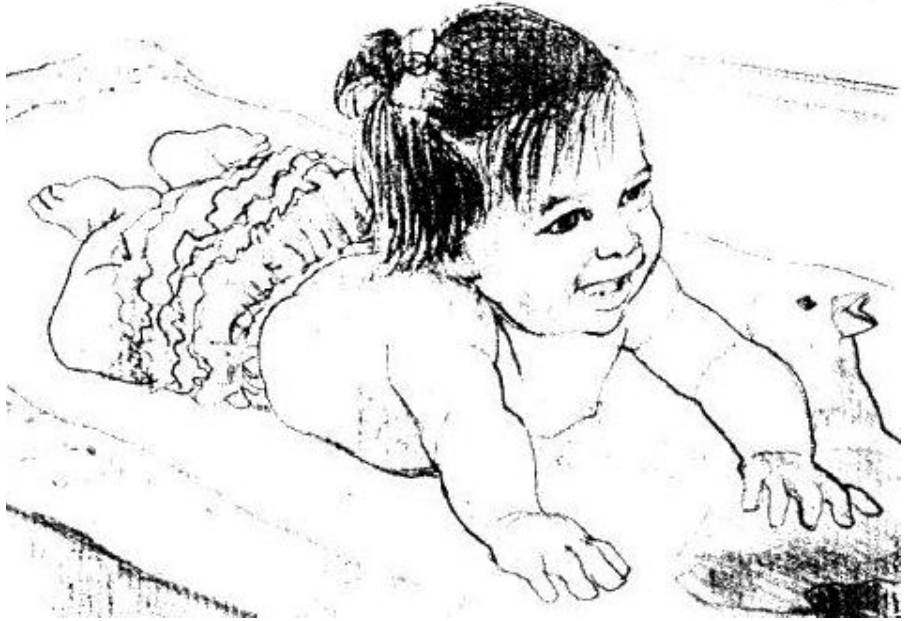
Figure 36. Time Out of Crib and Infant Seat.